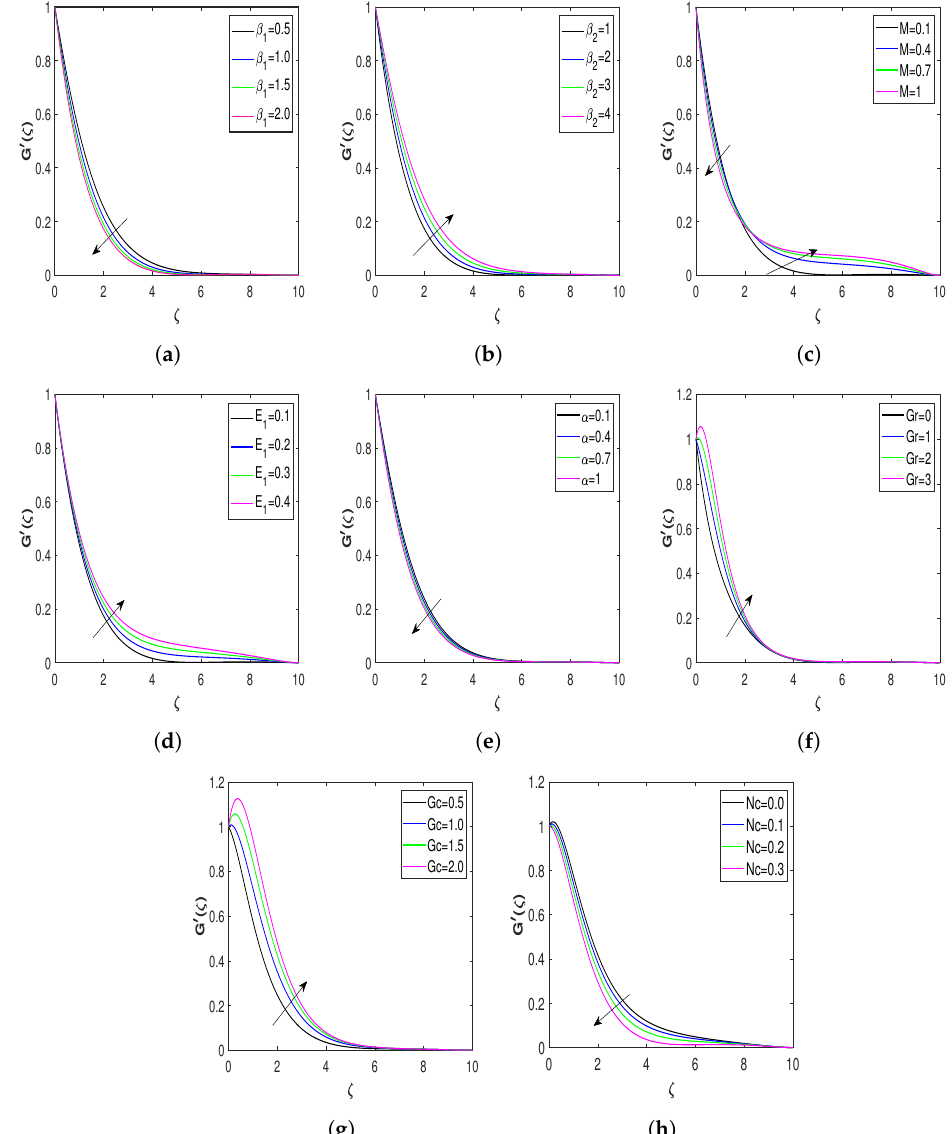
Figure 4. Nondimensional velocity profiles for different values of influential parameters. ( a ) Velocity profile against β 1 ; ( b ) velocity profile against β 2 ; ( c ) velocity profile against M ; ( d ) velocity profile against E 1 ; ( e ) velocity profile against α ; ( f ) velocity profile against Gr ; ( g ) velocity profile against Gc ; and ( h ) velocity profile against Nc